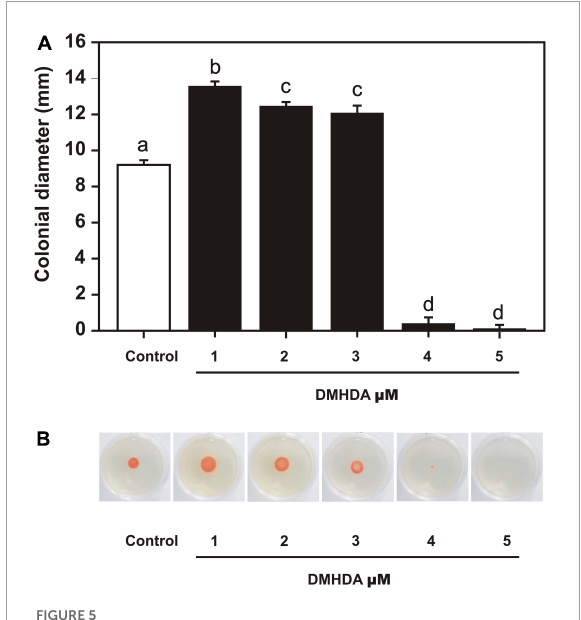
FIGURE5 The effect of dimethylhexadecylamine (DMHDA) on Arthrobacter sp. UMCV2 swarming motility. Nutrient agar plates were prepared with various concentrations of DMHDA and inoculated with 5 µ l bacterial suspension. After 72 h of culturing, colony diameters were measured. Bars, and error bars on panel (A) , represent the mean ± standard error values, respectively, for four biological replicates. Letters indicate means that differ significantly, following Duncan’s multiple range test ( p < 0.05). Panel (B) shows representative images of the